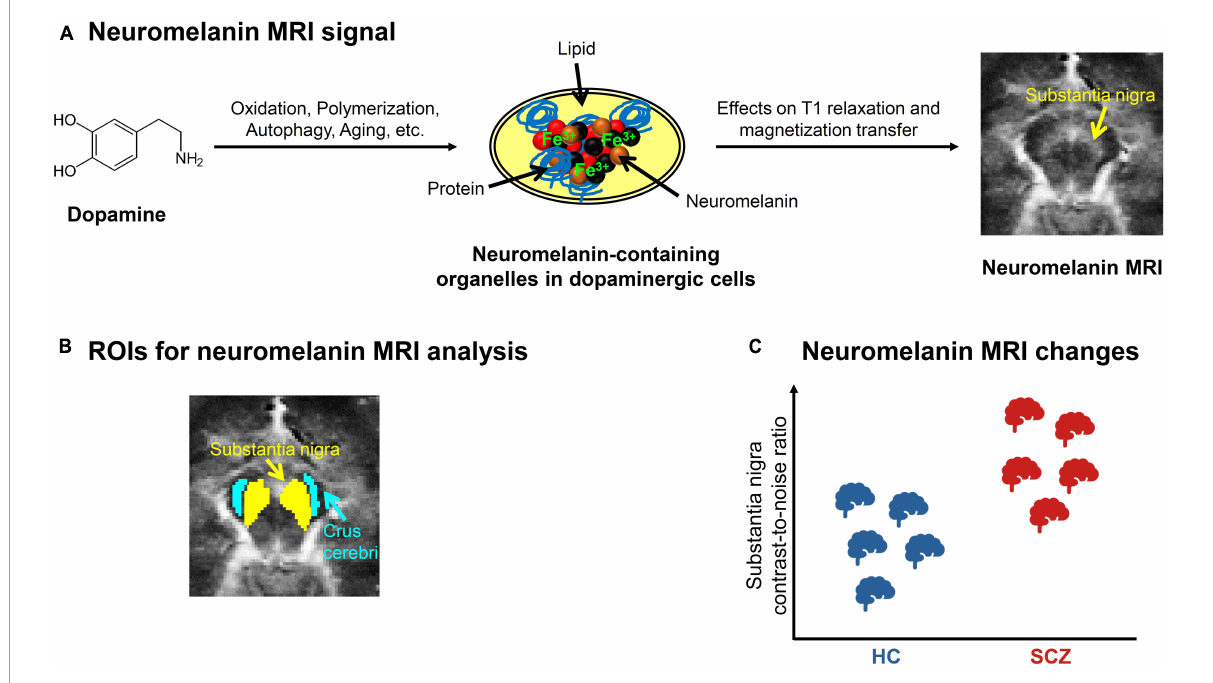
FIGURE2 Neuromelanin MRI in schizophrenia. (A) Neuromelanin MRI signal. Schematic depiction of the metabolization of dopamine into neuromelanin-containing organelles and how neuromelanin influences the magnetic resonance imaging (MRI) signal. On the right, an exemplary preprocessed neuromelanin MRI image of one healthy subject is shown, with focus on the mesencephalon. (B) ROIs for neuromelanin MRI analysis. Typical regions of interest (ROIs) (43) used for contrast-to-noise-ratio analysis, which calculates the ratio between the MRI signals of substantia nigra and a reference region, e.g., crus cerebri. (C) Neuromelanin MRI changes in schizophrenia. Schematic depiction of the consistent elevation of substantia nigra contrast-to-noise-ratio in patients with schizophrenia (SCZ) compared to healthy controls (HC), based on meta-analytic evidence (40,